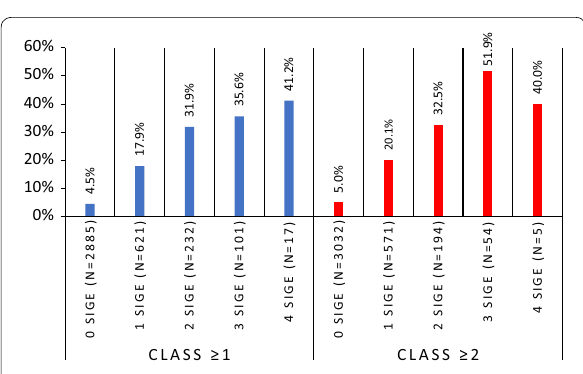
Fig. 5 Percentage of people with allergic multimorbidity by the number of positive allergen‑specific IgE assays (4 allergens: d1, e1, m6, g6). X axis—sIgE assay; Y axis—% of multimorbidity among those with positive sIgE for 0, 1, 2 and 3